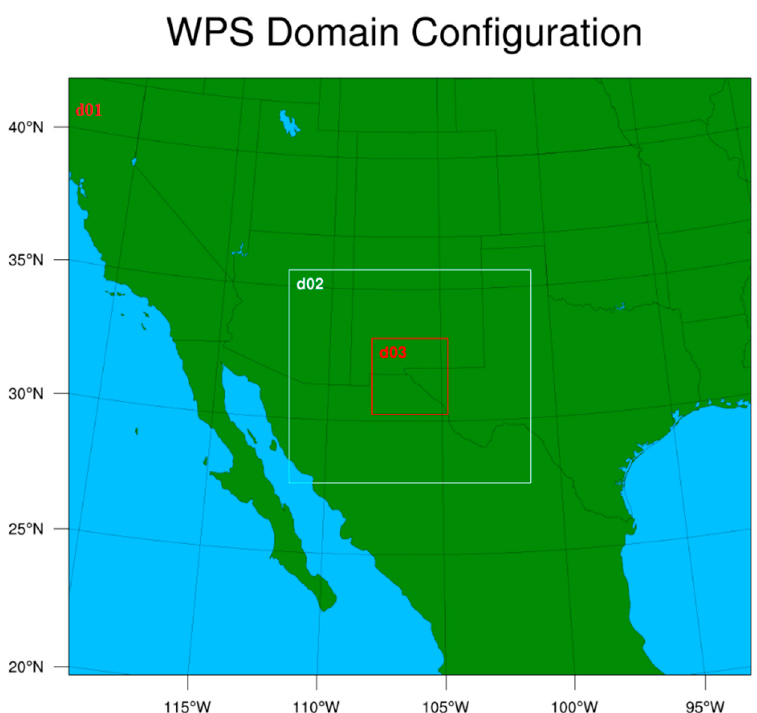
Figure 2. The domain used for the Weather Research and forecasting (WRF) simulations, with outer domain d01 with a resolution of 36 km × 36 km; d02 with a resolution of 12 km × 12 km; and inner domain d03 with a resolution of 4 km × 4 km. Table 1. WRF options used for the simulations.